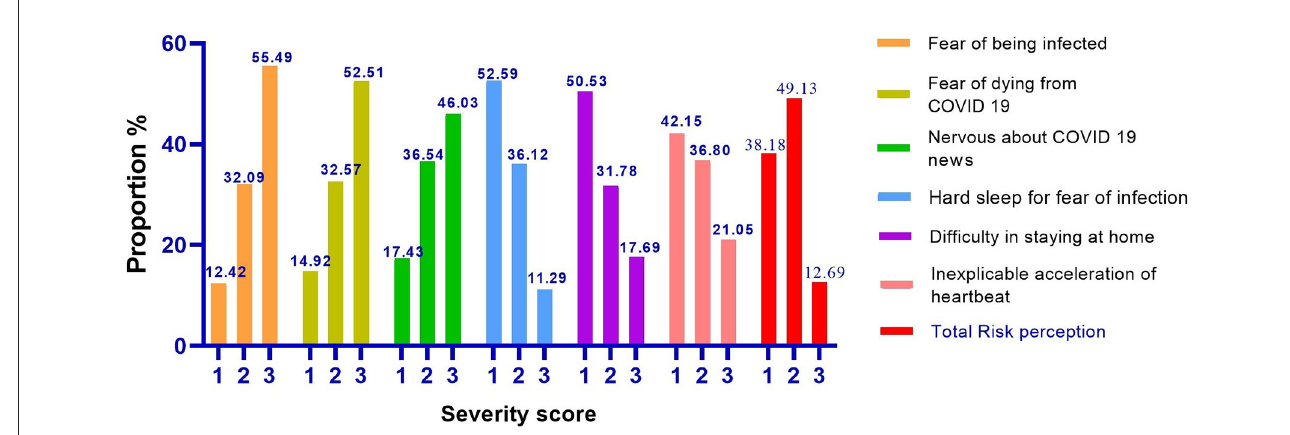
FIGURE2 Distribution of the answers related to the participants’ risk